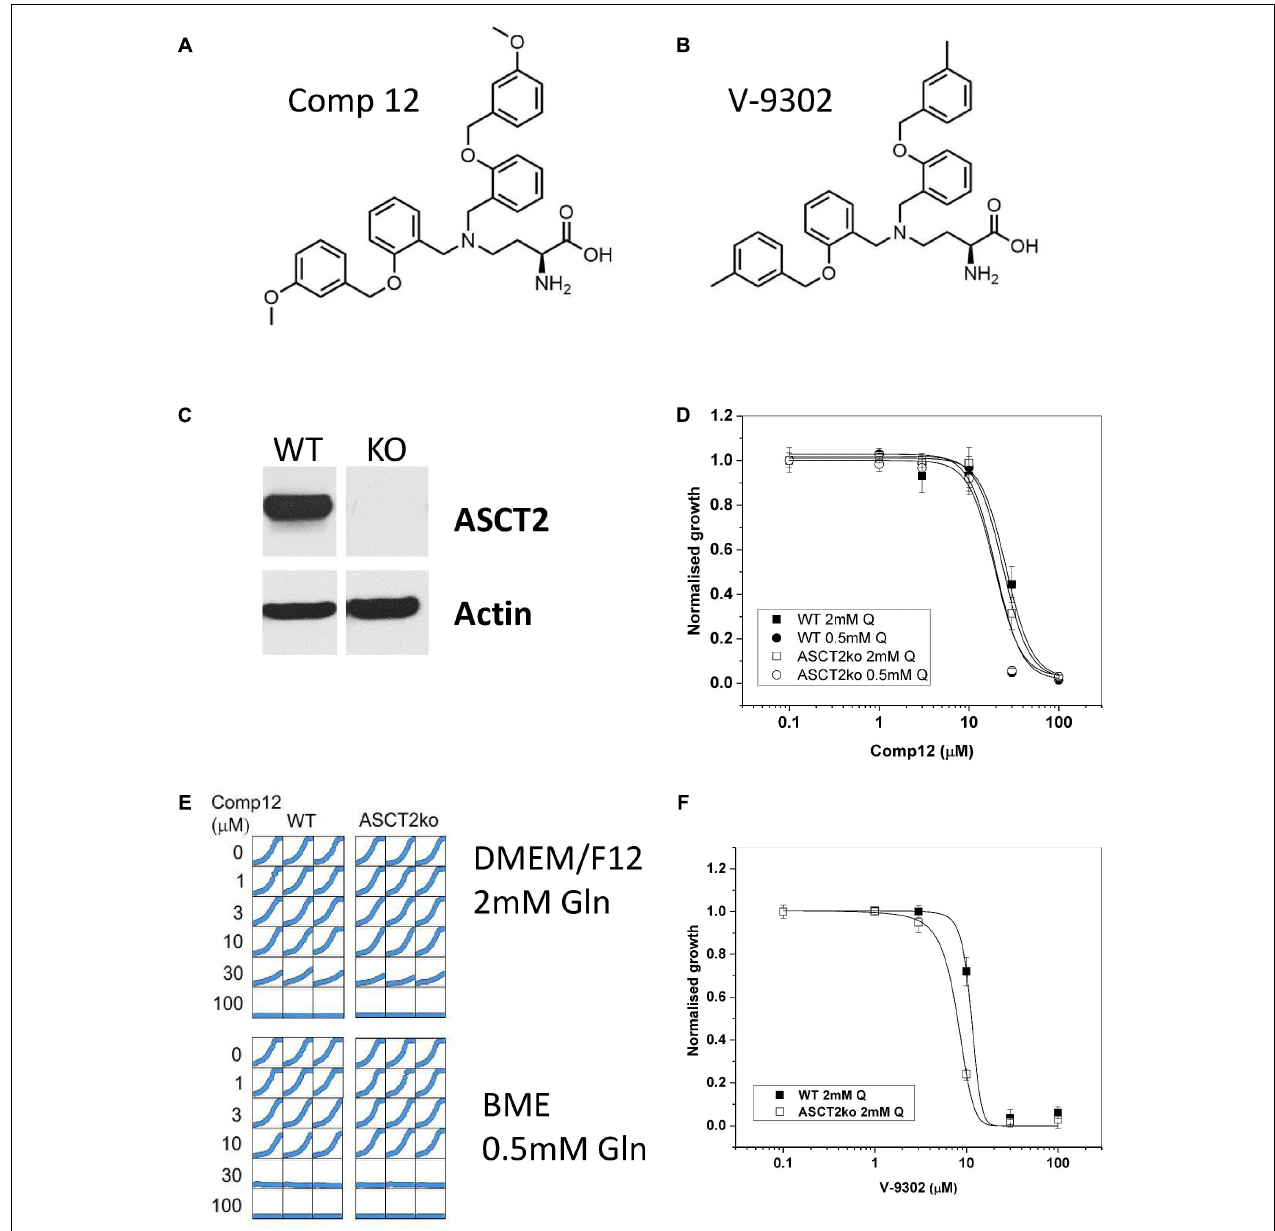
FIGURE 1 | Inhibition of tumor cell growth by AABA. Structure of 2-amino-4-bis(aryloxybenzyl)aminobutanoic acids compound 12 (A) and V-9302 (B) as described by Schulte et al. (2016, 2018). (C) The presence of ASCT2 in wild-type and genome-edited 143B cells was evaluated by western blotting of cell homogenates using an ASCT2-specific antibody. (D) Growth of parental and ASCT2ko 143B cells was monitored using IncuCyte technology in the presence of increasing concentrations of compound 12 ( n = 12, cells were seeded from at least three different batches). (E) Reproducibility of cell growth assays in a well-to-well comparison showing growth in DMEM/F12 supplemented with 2-mM glutamine and BME supplemented with 0.5-mM glutamine. Concentration of compound 12 is indicated in the margin. (F) Growth of parental and ASCT2ko 143B cells was monitored using IncuCyte technology in the presence of increasing concentrations of V-9302 ( n = 10, cells were seeded from at least three different